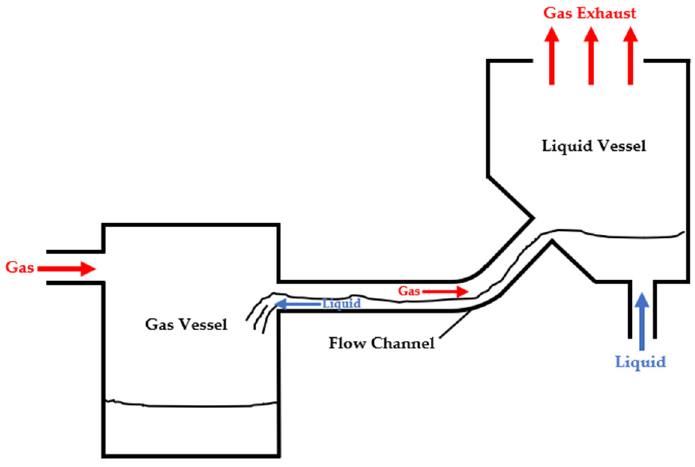
Figure 1. Schematic diagram of CCF.